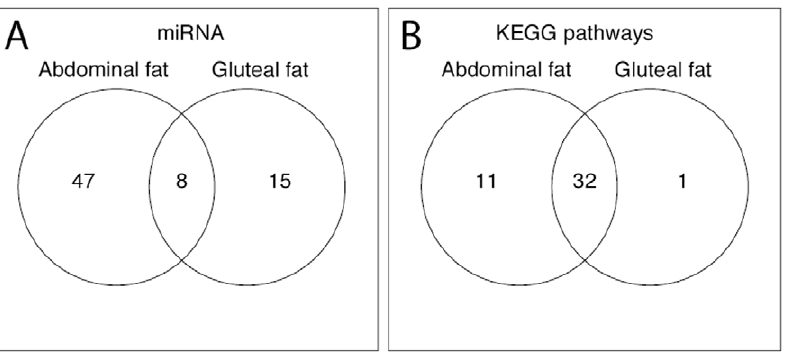
Figure 5. (A) Venn diagram showing the number of common and unique miRNAs with significant association to their target mRNAs in each adipose tissue type. (B) Venn diagram showing the number of common and unique KEGG terms in each adipose tissue type.